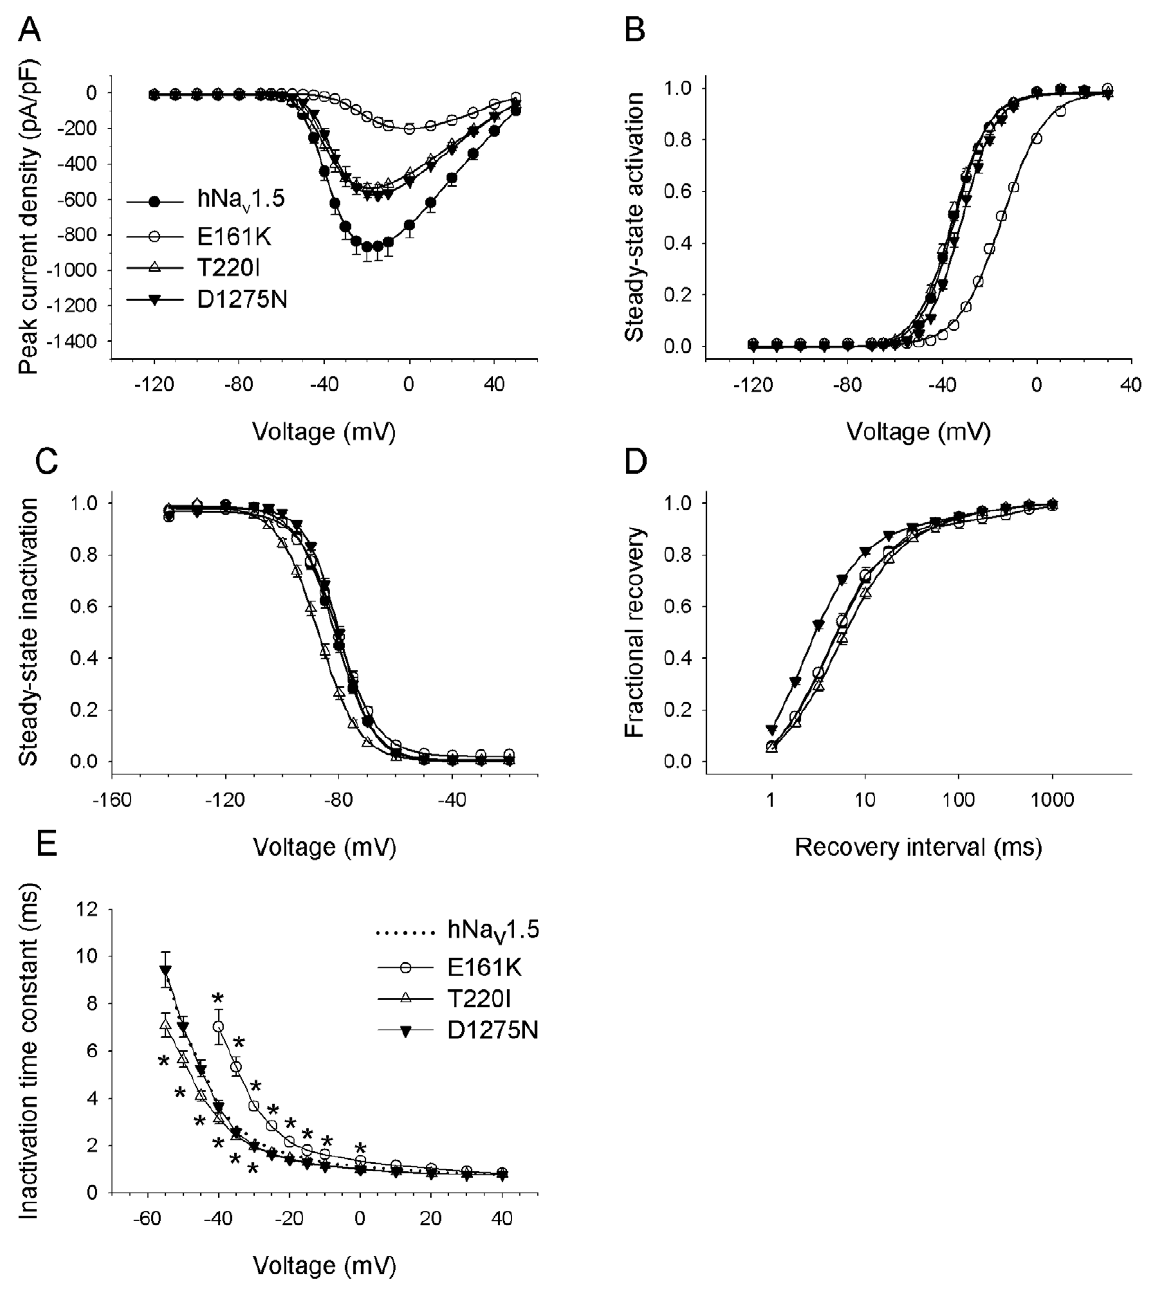
Figure 3. Electrophysiological properties of three group 2 mutant channels expressed by HEK293 cells. Individual parameters are summarized in Table 1. (A) Peak current-to-voltage ( I–V ) relationships. Currents were elicited from the holding potential of 2 120 mV to the indicated test potentials. (B) Steady-state activation as a function of voltage. (C) Steady-state inactivation as a function of voltage. (D) Recovery from inactivation. (E) Time constant of inactivation ( t h ) as function of voltage. Error bars represent the mean 6